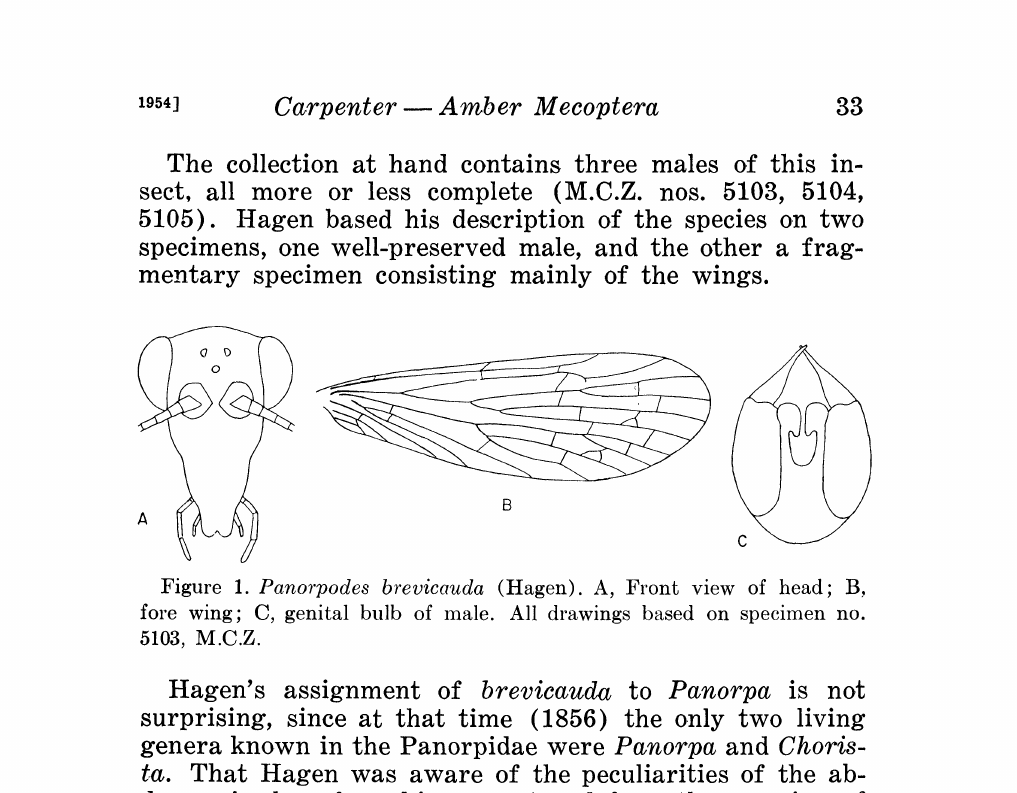
Figure 1. Panorpodes brevicauda (Hagen). A, Front view of head; B, fore wing; C, genital bulb of male. All drawings based on specimen no. 5103,